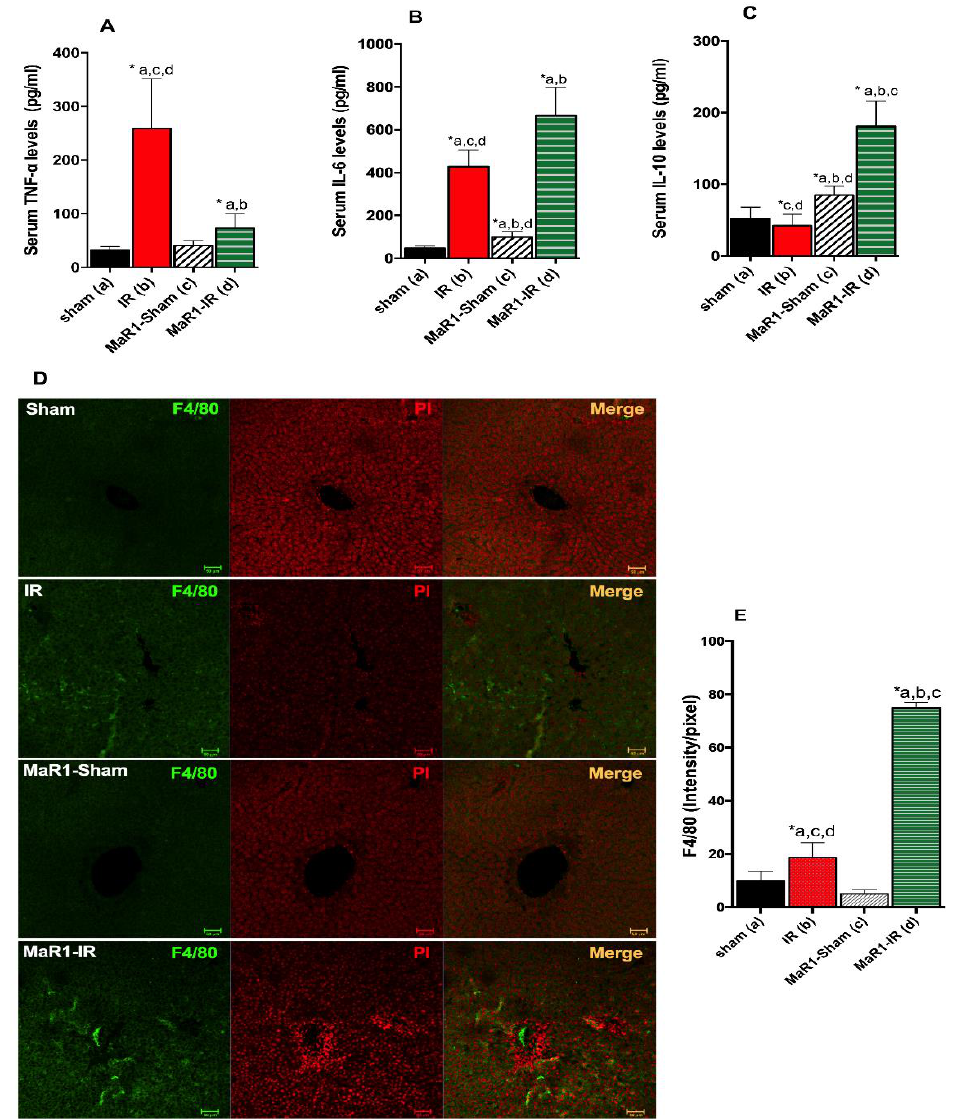
Figure 6. Effect of MaR1 on inflammatory response. Serum levels of inflammatory cytokines ( A ) tumor necrosis factor (TNF)-α, ( B ) interleukin (IL)-6 and anti-inflammatory cytokine, and ( C ) IL-10 levels after IR were quantified. ( D ) Representative images depicting hepatic macrophages stained with the F4/80 marker in green and nuclei in red (propidium iodine), assessed by immunofluorescence in paraffined fixed liver tissues. ( E ) The fluorescence intensity was evaluated. The plots are represented as mean ± SEM, n = 4 rats per experiment, Image fields measured per rats >6. Significance was assessed by one-way ANOVA and the Tukey’s post-test. Asterisk indicates p < 0.05, and the letters identify the experiments that are compared and present this statistical difference. Scale bar indicates 50 µm.